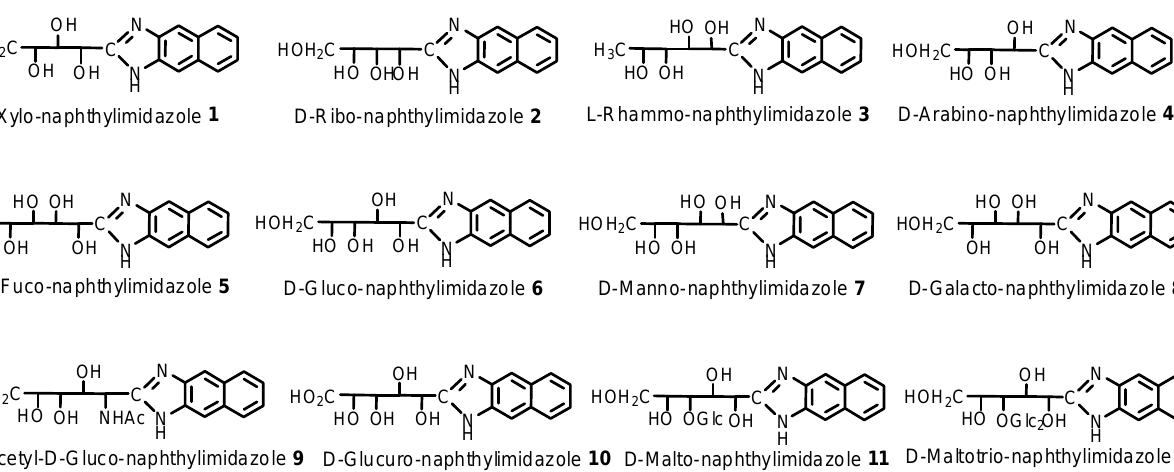
Figure 1. Structures of aldo-naphthimidazole compounds used for monosaccharide compositional analysis by capillary